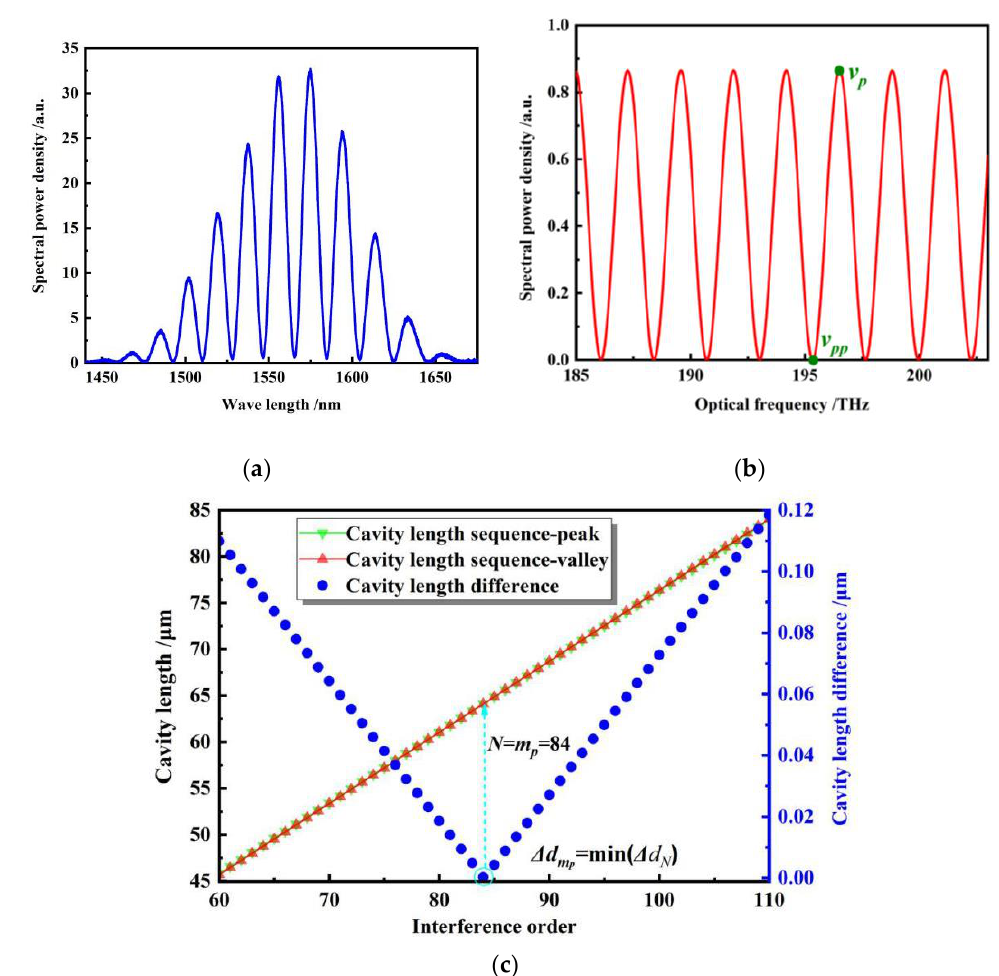
Figure 6. Spectra and cavity length sequences for a 64.1130- μm fiber-optic FP sensor. ( a ) Reflection spectrum; ( b ) corrected spectrum in the frequency domain; ( c ) generated cavity length sequences and their differences.